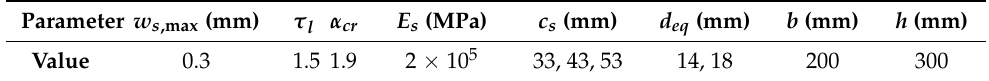
Table 7. Variables involved in